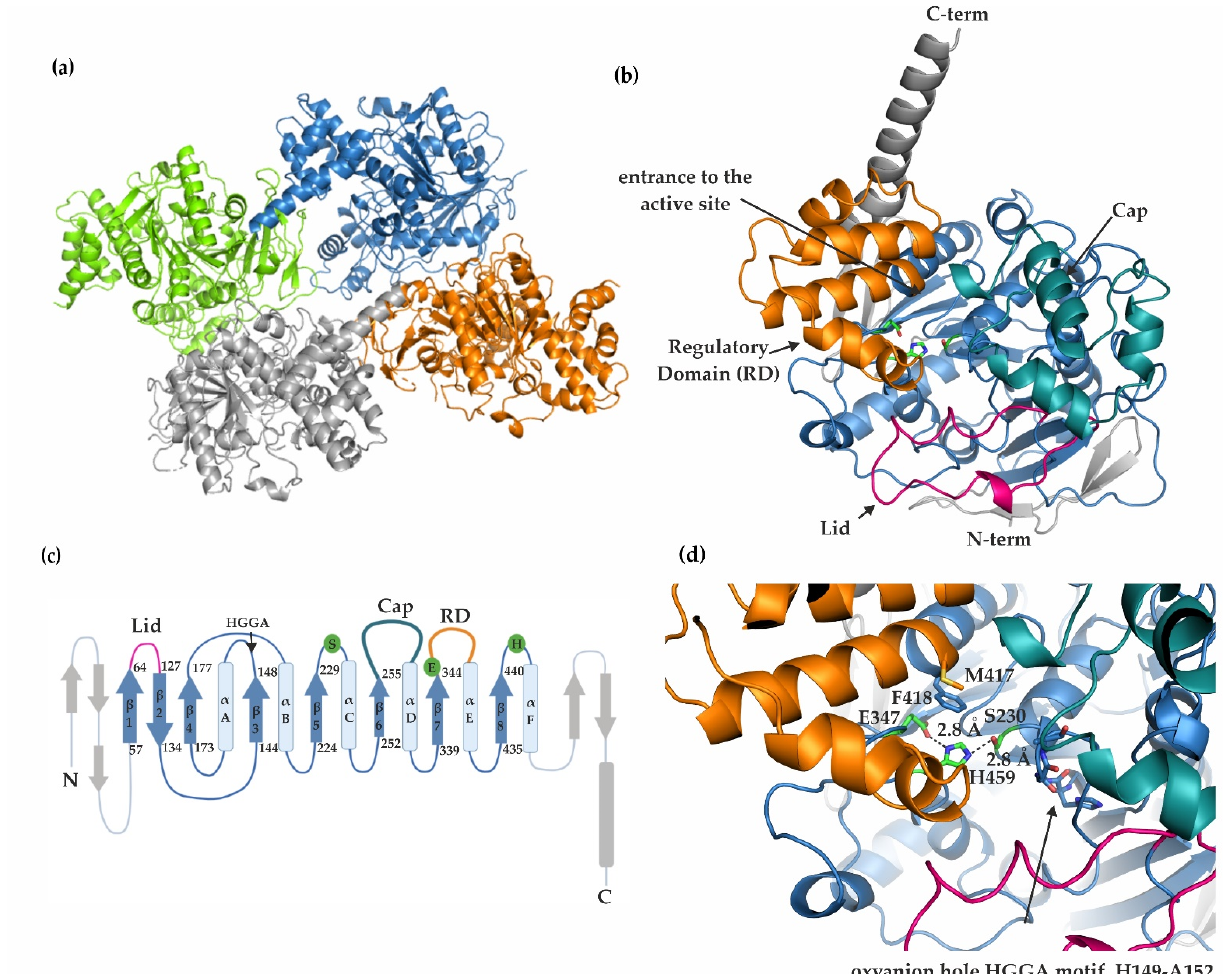
Figure 2. Overall structure of mCes2c. ( a ) The asymmetric unit includes 4 molecules, chain A is shown in green, chain B in blue, chain C in orange, and chain D in gray. ( b ) mCes2c in cartoon representation. The structure shows a conserved α / β -hydrolase fold typically for mammalian carboxylesterases (shown in blue). The catalytic triad residues S230, E347, and H459 are represented as green sticks. The lid is depicted in pink, the cap in teal and the regulatory domain (RD) in orange. Distinct sites as discussed in the paper are indicated with arrows. ( c ) Topology diagram of mCes2c. mCes2c harbors an α / β -hydrolase fold with eight mostly parallel β -strands, whereby only the second strand is antiparallel; the strands are connected by six α -helices. The positions of the catalytic residues in the loops connecting strands and helices are conserved, namely: the nucleophilic serine after strand β 5, the acidic residue positioned after strand β 7, and the conserved histidine after strand β 8. Please note that secondary structural elements are not included for the additional modules such as the lid, the cap, and the RD; loop regions are not to scale. ( d ) The active site residues S230, E347, and H459 are indicated as green sticks. Distances of the H-bonding network and the oxyanion hole motif are indicated. The gate M417(orange) and switch F418 (blue) residues are shown in sticks and are highly conserved among hCES1, hCES2, and mCes2c (see also Supplementary Figure